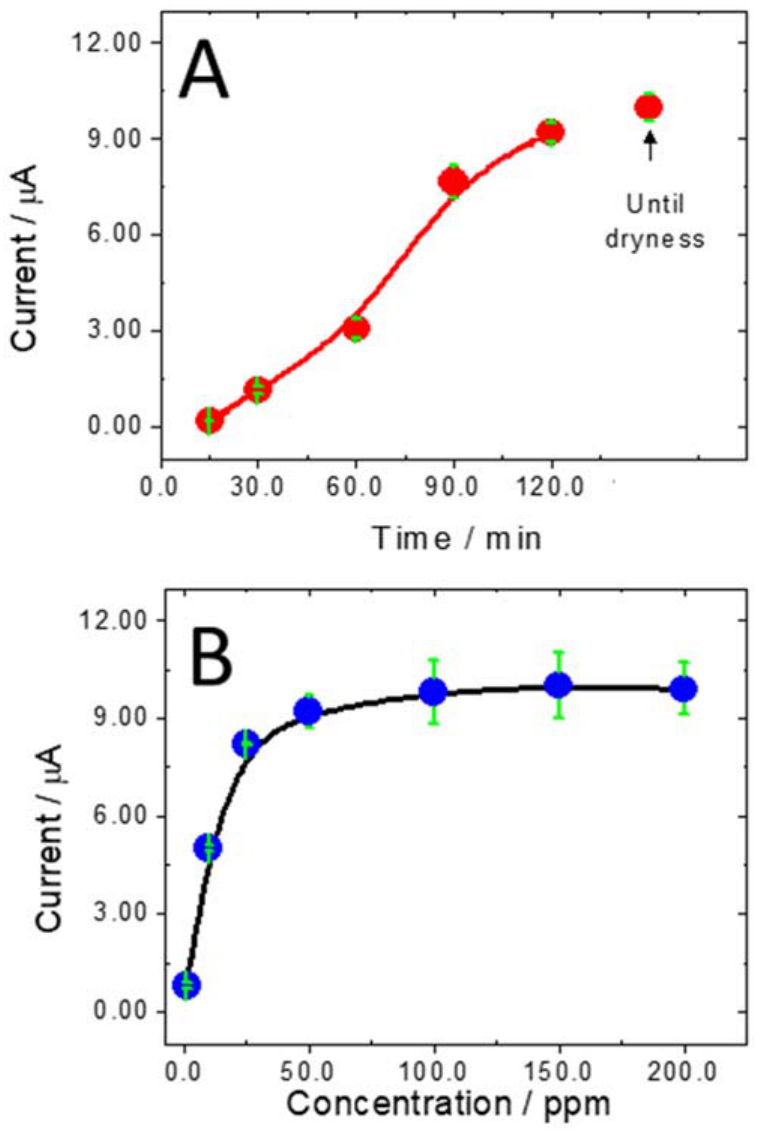
Figure 4. ( A ) Influence of the accumulation time of oligo 21 at GCE/MWCNTs-PolyArg on the guanine oxidation peak current. Oligo 21 concentration: 100 ppm. ( B ) Effect of oligo 21 concentration deposited at GCE/MWCNTs-PolyArg on the guanine oxidation peak current. Accumulation time: until dryness. Other conditions are as in Figure 3.